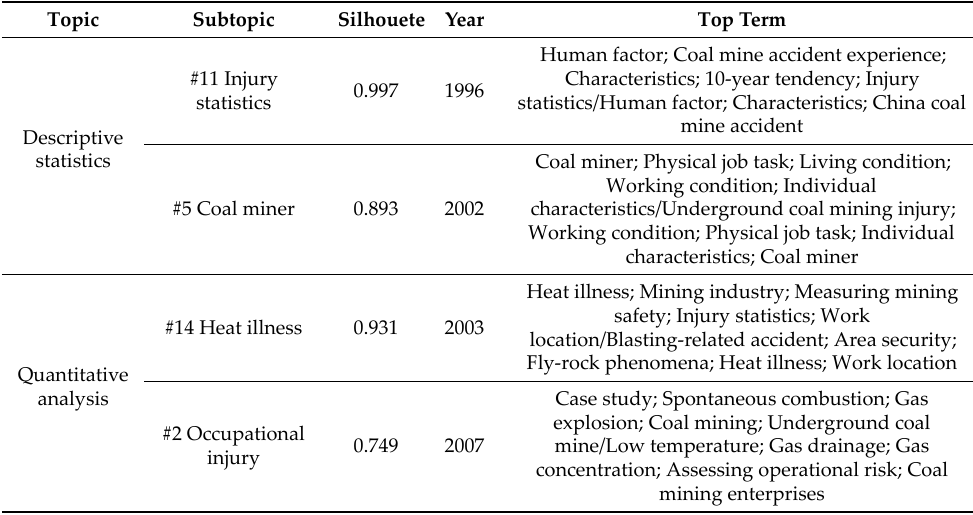
Table 4. Topic and top term of occupational injuries.